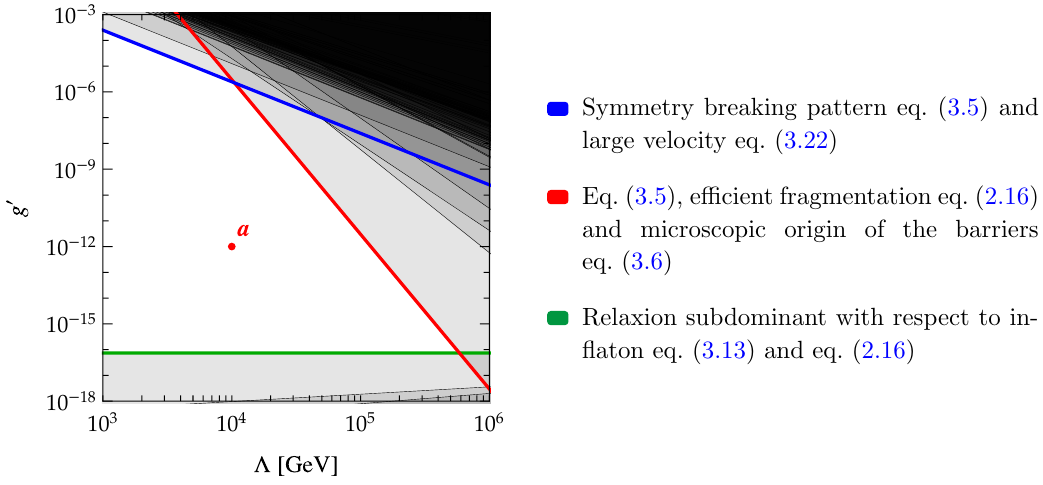
Figure 17 . Details of the origin of the constraints delimitating the blue region presented in sec- tion 3.1 and (cid:12)gure 2 corresponding to the case where relaxation happens through Higgs-dependent barriers, during a stage of in(cid:13)ation, where the relaxion is a subdominant component of the energy density of the universe and where the relaxion stops because of fragmentation .